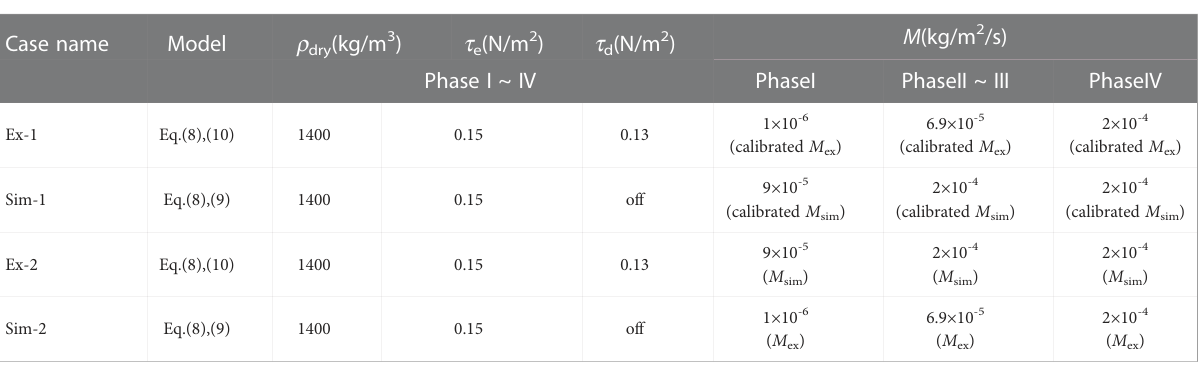
TABLE 1 Simulation codes with different